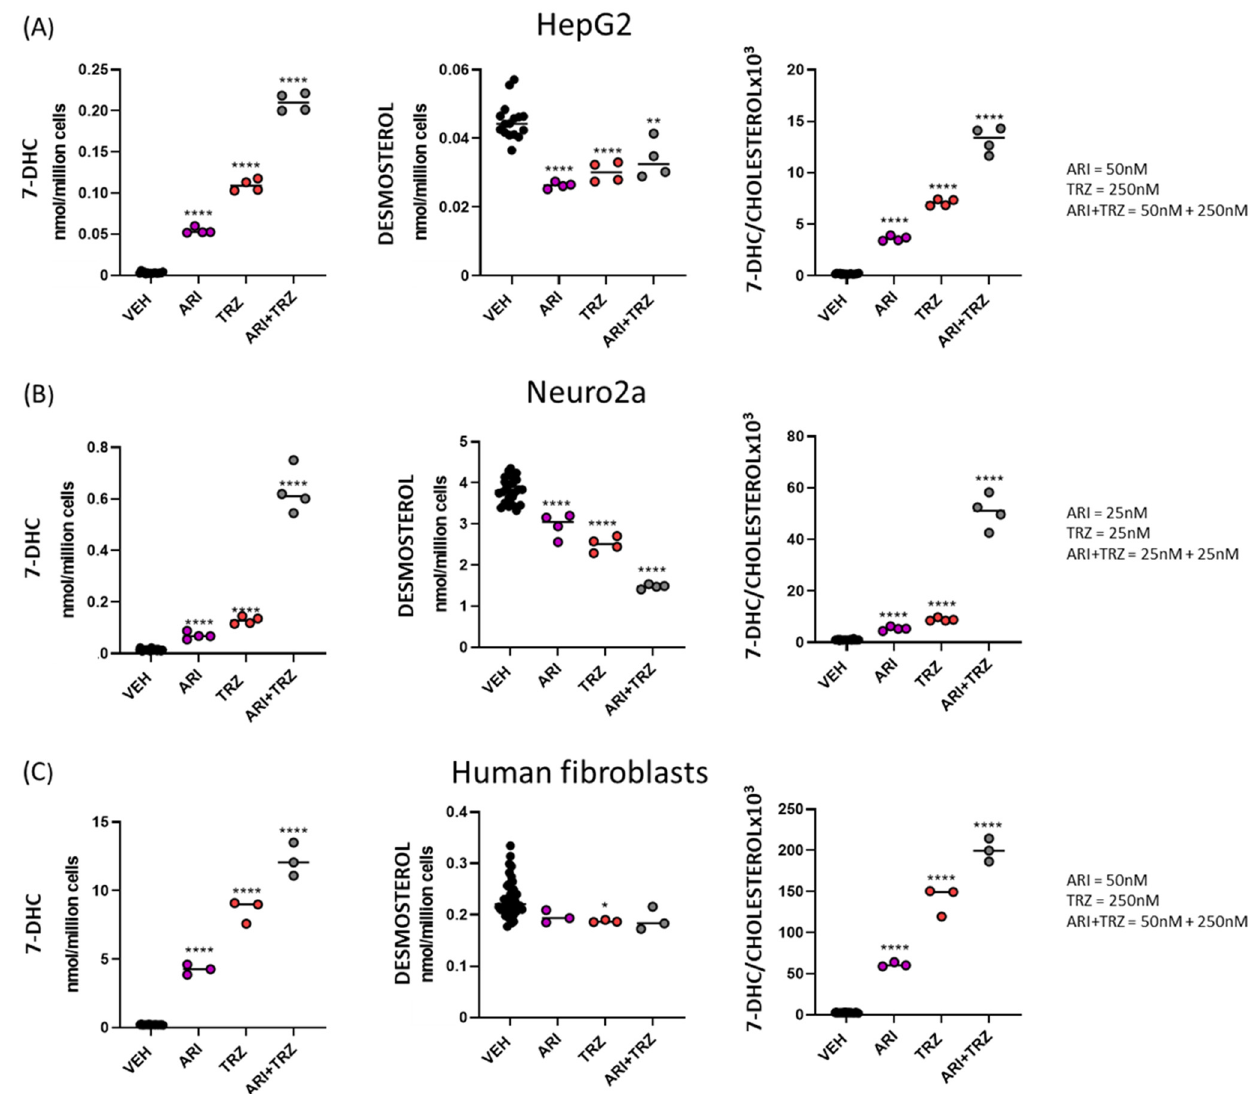
Figure 2. ARI, TRZ, and the combination of both significantly alter sterol biosynthesis. ( A ) HepG2, ( B ) Neuro2a, and ( C ) human fibroblasts. 7-DHC, DES levels and 7-DHC/CHOL ratio are shown. Data are presented for vehicle treatment, ARI, TRZ, and ARI + TRZ with concentrations indicated on the right side of each graph set. Treatments compared to vehicle exposure that reached significance are marked with black asterisks. * p < 0.05, ** p < 0.01, **** p < 0.0001.